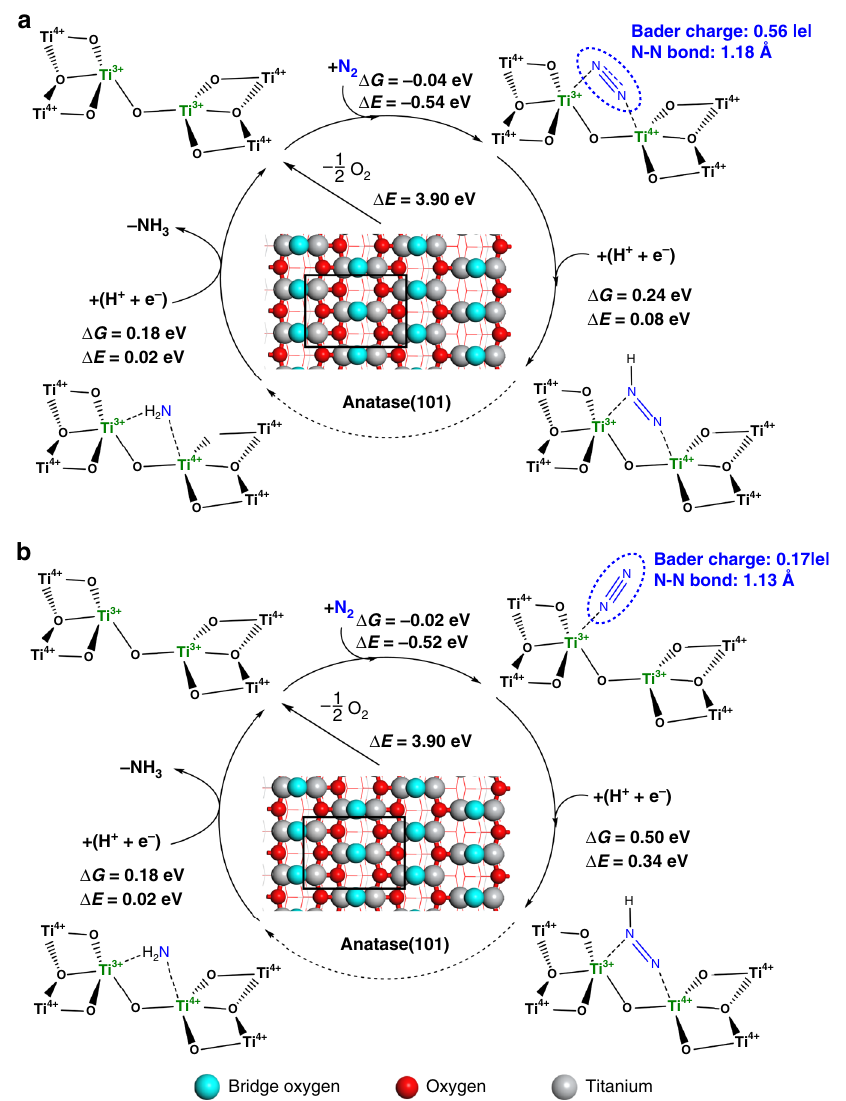
Fig. 3 DFT predicted activity for different types of Ti 3 + site. a adjacent bi-Ti 3 + on anatase (101) surfaces with oxygen vacancy, b single Ti 3 + on anatase (101) surfaces with oxygen vacancy. The light-blue spheres stand for the lattice oxygens at the bridge sites where the surface oxygen vacancies are formed most easily. The red spheres stand for the other lattice oxygens on the surfaces and the gray spheres stand for the titanium cations. Δ G refers to the free energy, and Δ E refers to the electronic energy. The Vo formation energy, Δ E (Vo), was calculated in related to the 1/2 O 2 formation as described in